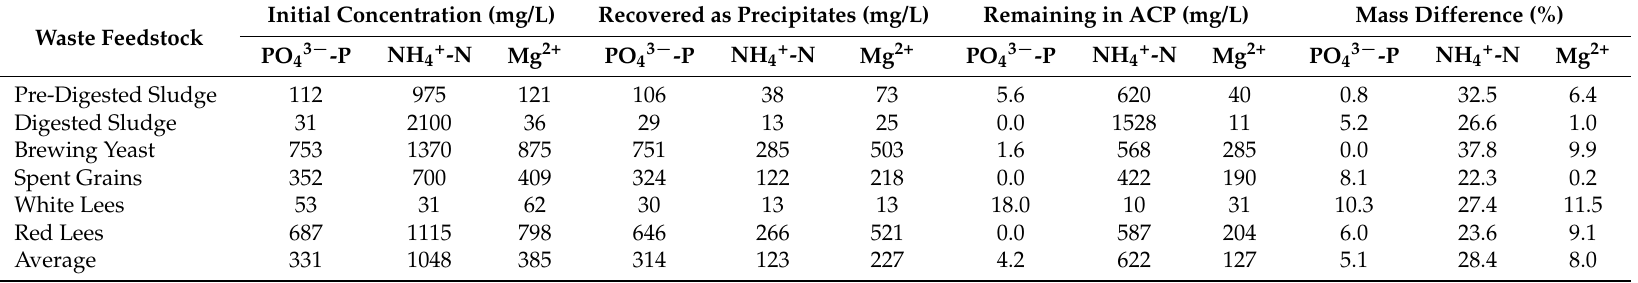
Table 3. Experimental results for pre- and post-precipitation concentrations of nitrogen (N) and phosphorus (P), with additional mass balance information for PO 43 − , NH 4+ , and magnesium (Mg 2+